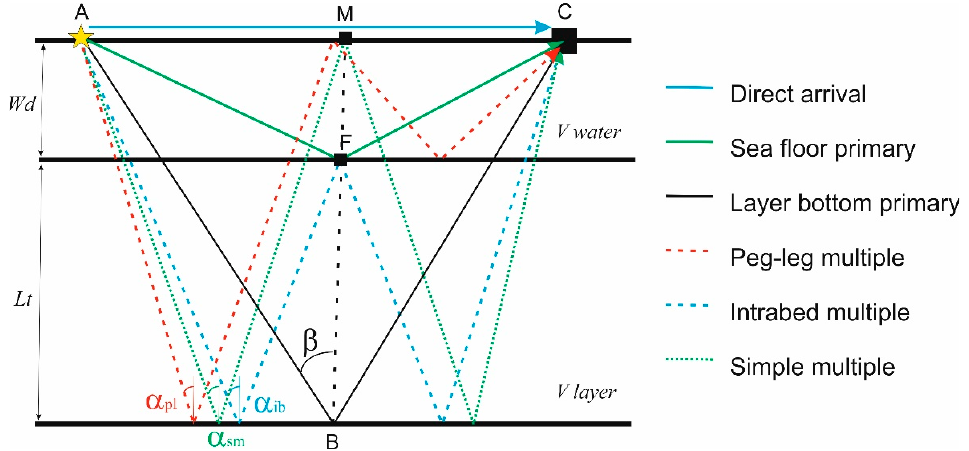
Figure 1. Ray paths for direct, primary and multiple reflected arrivals, approximated by straight lines. Point M is the mid-point between source in A and receiver in C; F and B are the reflection point from the sea floor and the layer base, respectively.